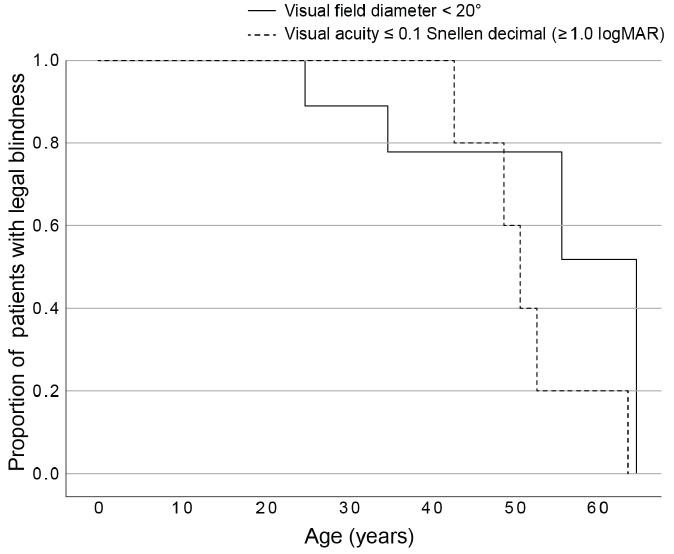
Figure 4. Kaplan Meier survival analysis plot showing the percentage of patients reaching legal blindness based on visual field (solid line ) or visual acuity (dashed line ).